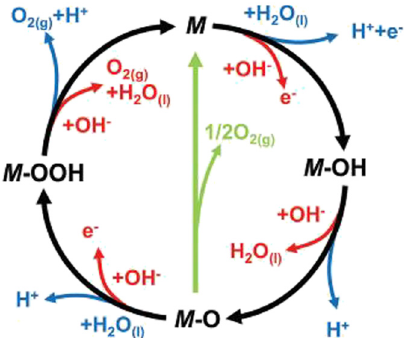
Figure 3: The OER technique in acidic ( blue line ) and basic ( red line ) solutions. The black line shows that the OER connects the produc - tion of a peroxide ( M – OOH ) intermediate ( black line ) with the for - mation of oxygen, while another way to form oxygen is the reaction of two adjoining oxo ( M – O ) intermediates ( green ) . Redrawn from [ 67 ] ; copyright 2017, Royal Society of